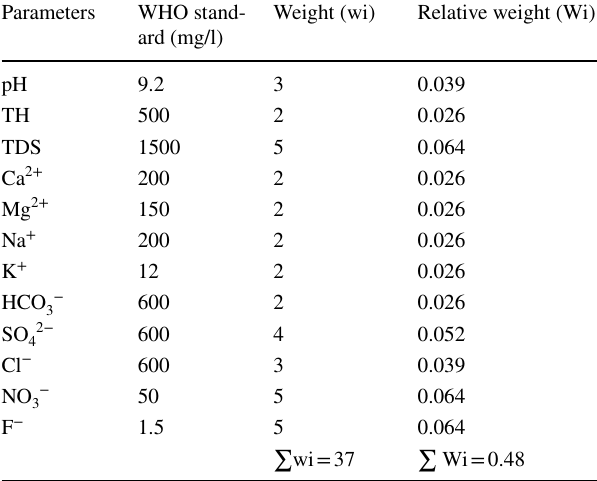
Table 1 Chemical parameters and their relative weight Parameters